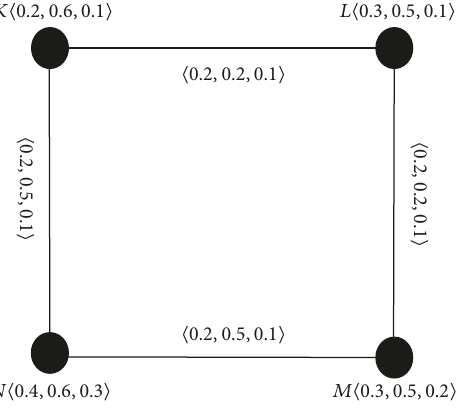
Figure 2: An edge regular 𝑚 -polar fuzzy graph 𝐺 .